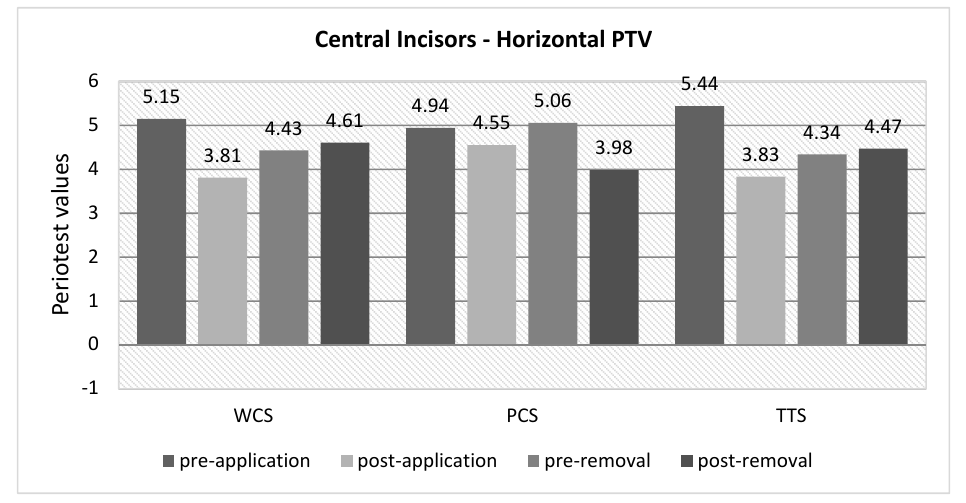
Figure 5. Vertical Periotest values for central incisors.